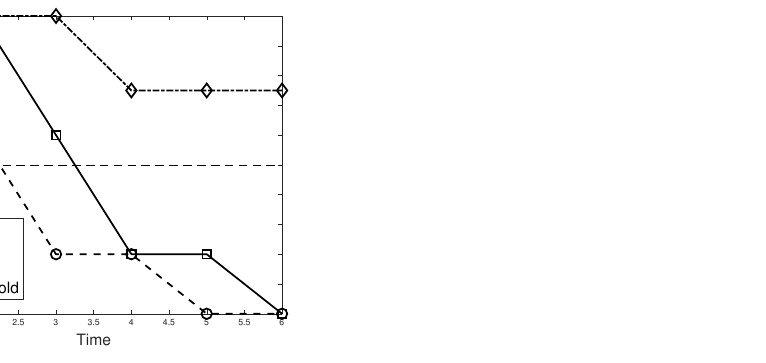
Figure 4. A sample of the number of vehicles on links 3, 4, and 5 over time using our proposed approach. In this realization, the number of links on link 5 is above the